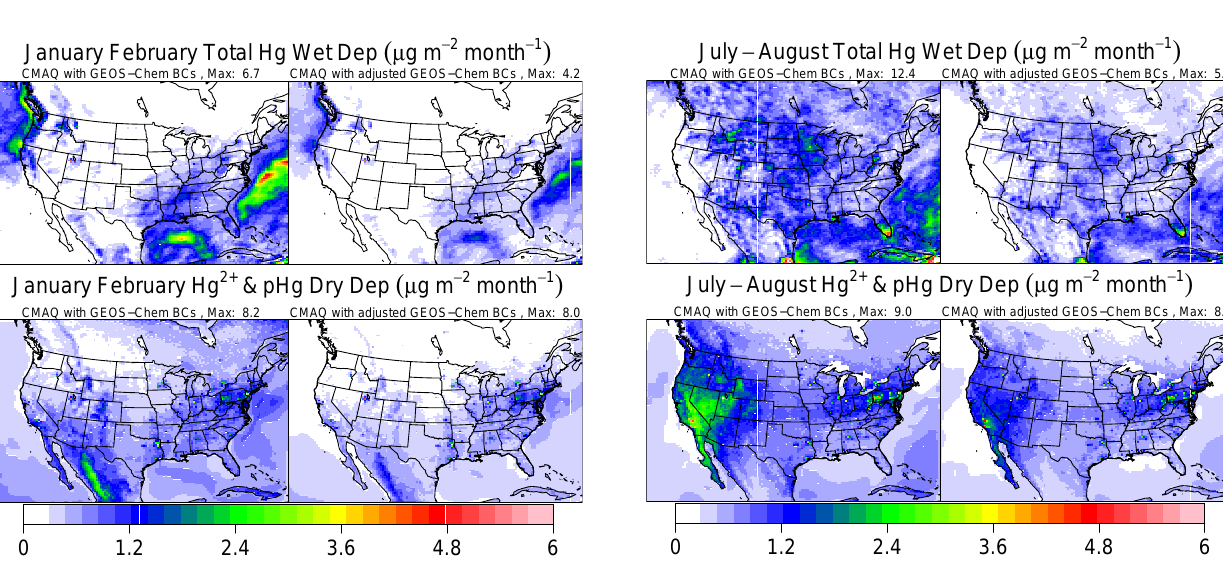
Fig. 5a. Comparison of simulated dry and wet mercury deposition for January–February 2002 from CMAQ runs using original GEOS- Chem based boundary conditions and adjusted boundary condi- tions. Circles on wet deposition plots indicate locations of Mercury Deposition Network wet deposition observations. Dry deposition includes only divalent forms of mercury.